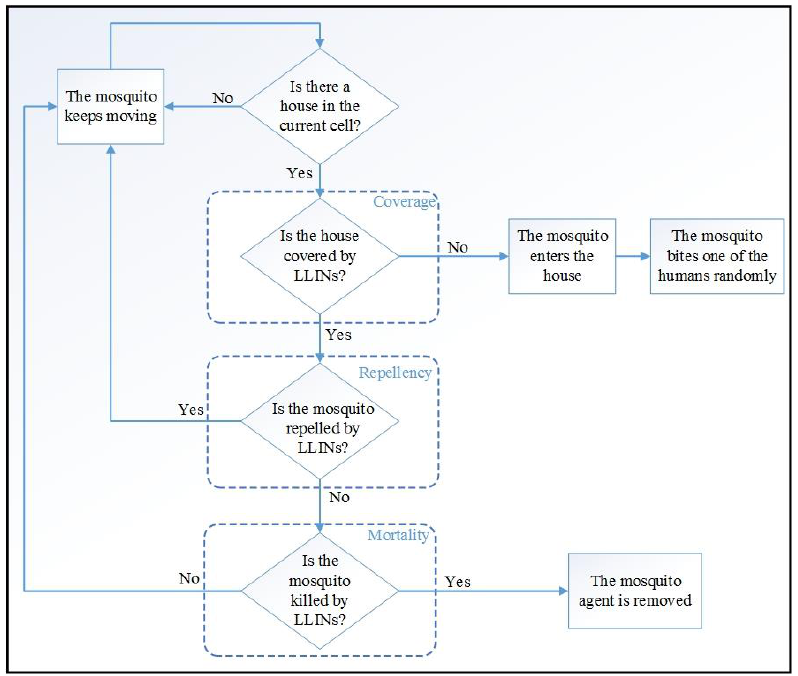
Figure 4. Flowchart of Long-Lasting Insecticidal Nets’ (LLINs) role.